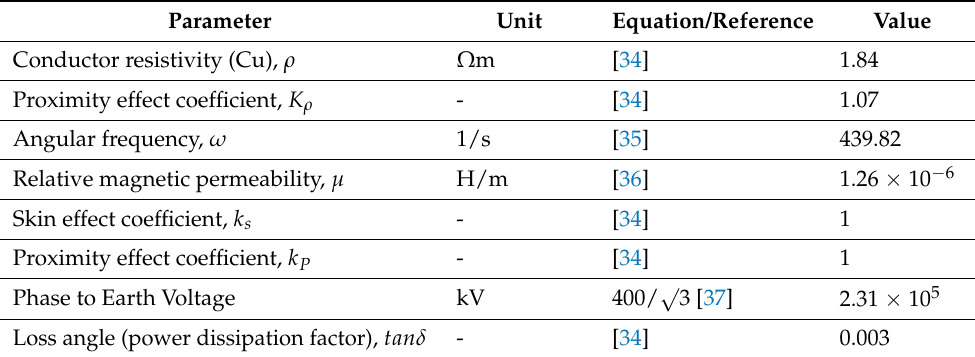
Table 2. List of parameters used in the calculation of conductor and dielectric heat losses. Parameter